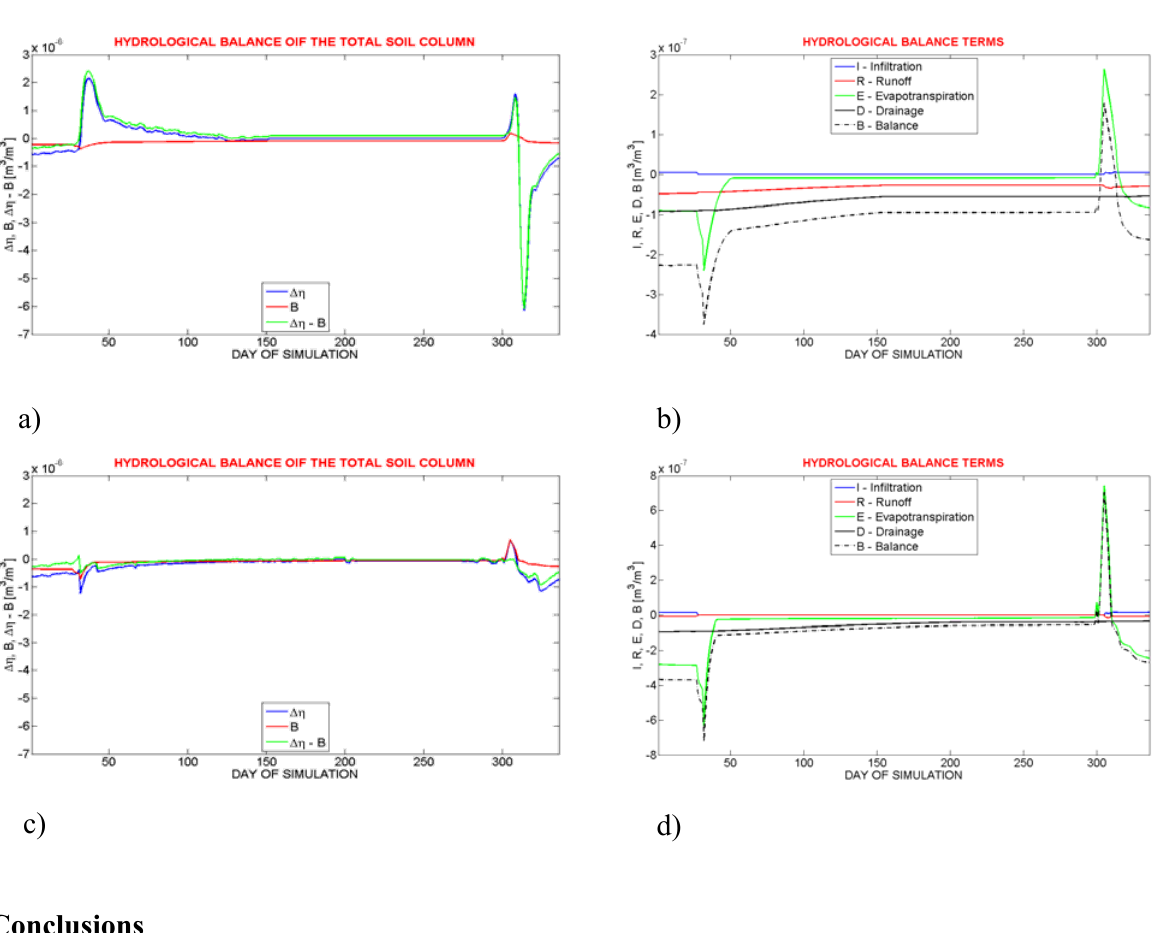
Figure 17. Hydrological balance and its components with (a, b) and without (c, d) the correction for the water overproduction and relative to the parameterization V. Notice the different scales of the plots (10 -6 for the hydrological balance, 10 -7 for the